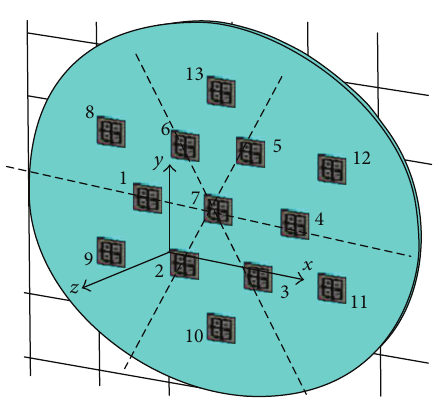
Figure 9: 13 elements array configuration—3D view.